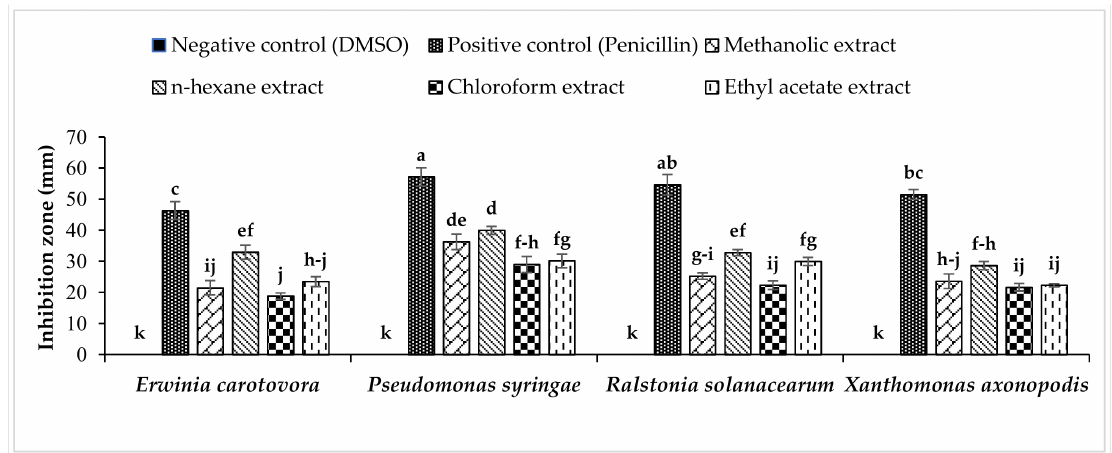
Figure 1. E ff ect of di ff erent organic solvent extracts of Cornus macrophylla leaves on the growth of Erwinia carotovora , Pseudomonas syringae , Ralstonia solanacearum, and Xanthomonas axonopodis . Vertical bars show the standard error of means of three replicates. Values with di ff erent letters show a significant di ff erence ( p ≤ 0.05) as determined by ANOVA followed by Fisher’s least significant di ff erence (LSD) Test using Minitab statistical software (Minitab